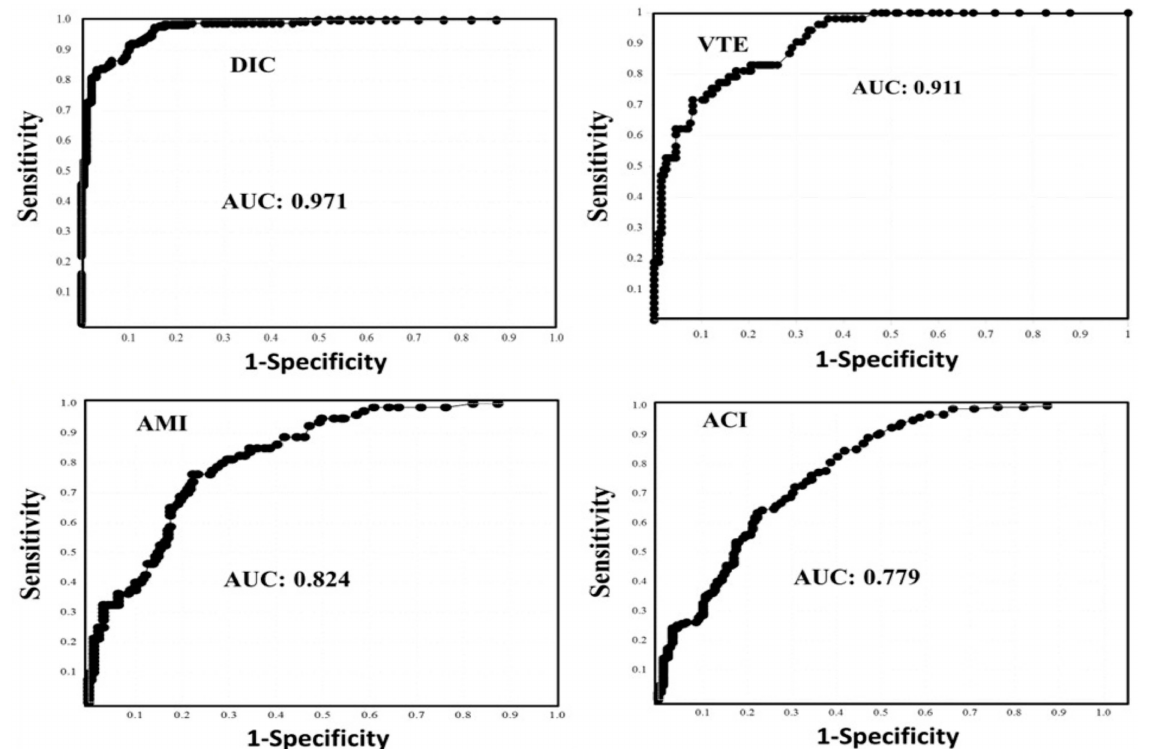
Figure 2. The receiver operating characteristic analysis of soluble fibrin for the diagnosis of throm- bosis vs. unidentified clinical syndrome and healthy volunteers. DIC, disseminated intravascular coagulation; VTE, venous thromboembolism, AMI, acute myocardial infarction; ACI, acute cerebral infarction; AUC, area under the curve.